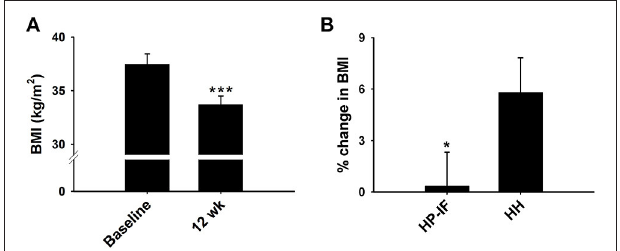
FIGURE 2 | Dietary effects on BMI during phase 1 (A) and phase 2 (B) collapsed across genders. (A) Effect of 12 week HP-IF-LC intervention (Phase 1) on BMI ( n = 40). (B) Percent change in BMI between HP-IF and HH groups during Phase 2 ( n = 24). ***Significant difference compared to baseline ( p < 0.001). *Trend for significant difference compared to HH group ( p = 0.069). BMI, body mass index; HP-IF, high-protein, intermittent fasting; HH, heart healthy.